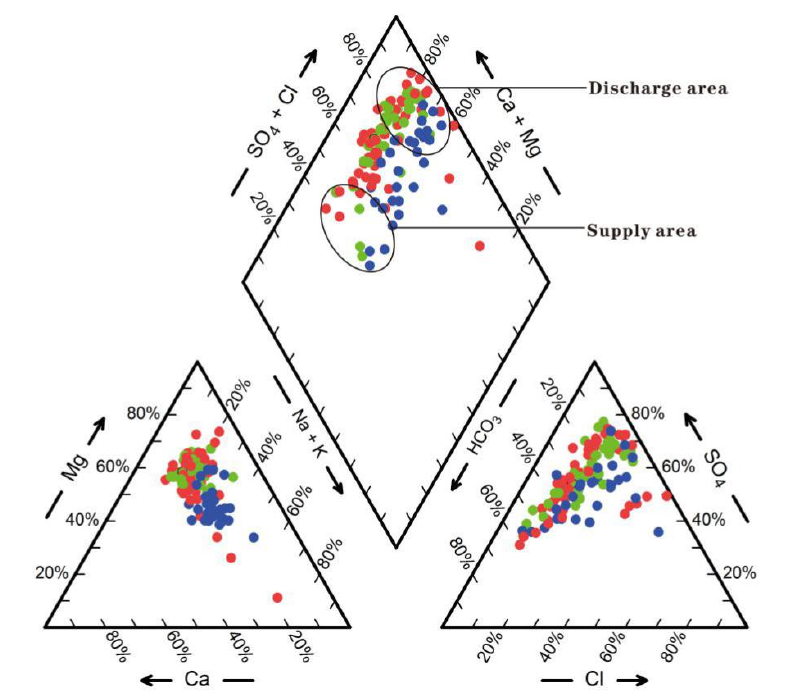
Figure 3. Piper three-line diagram of shallow groundwater in the Jinta Basin, China.